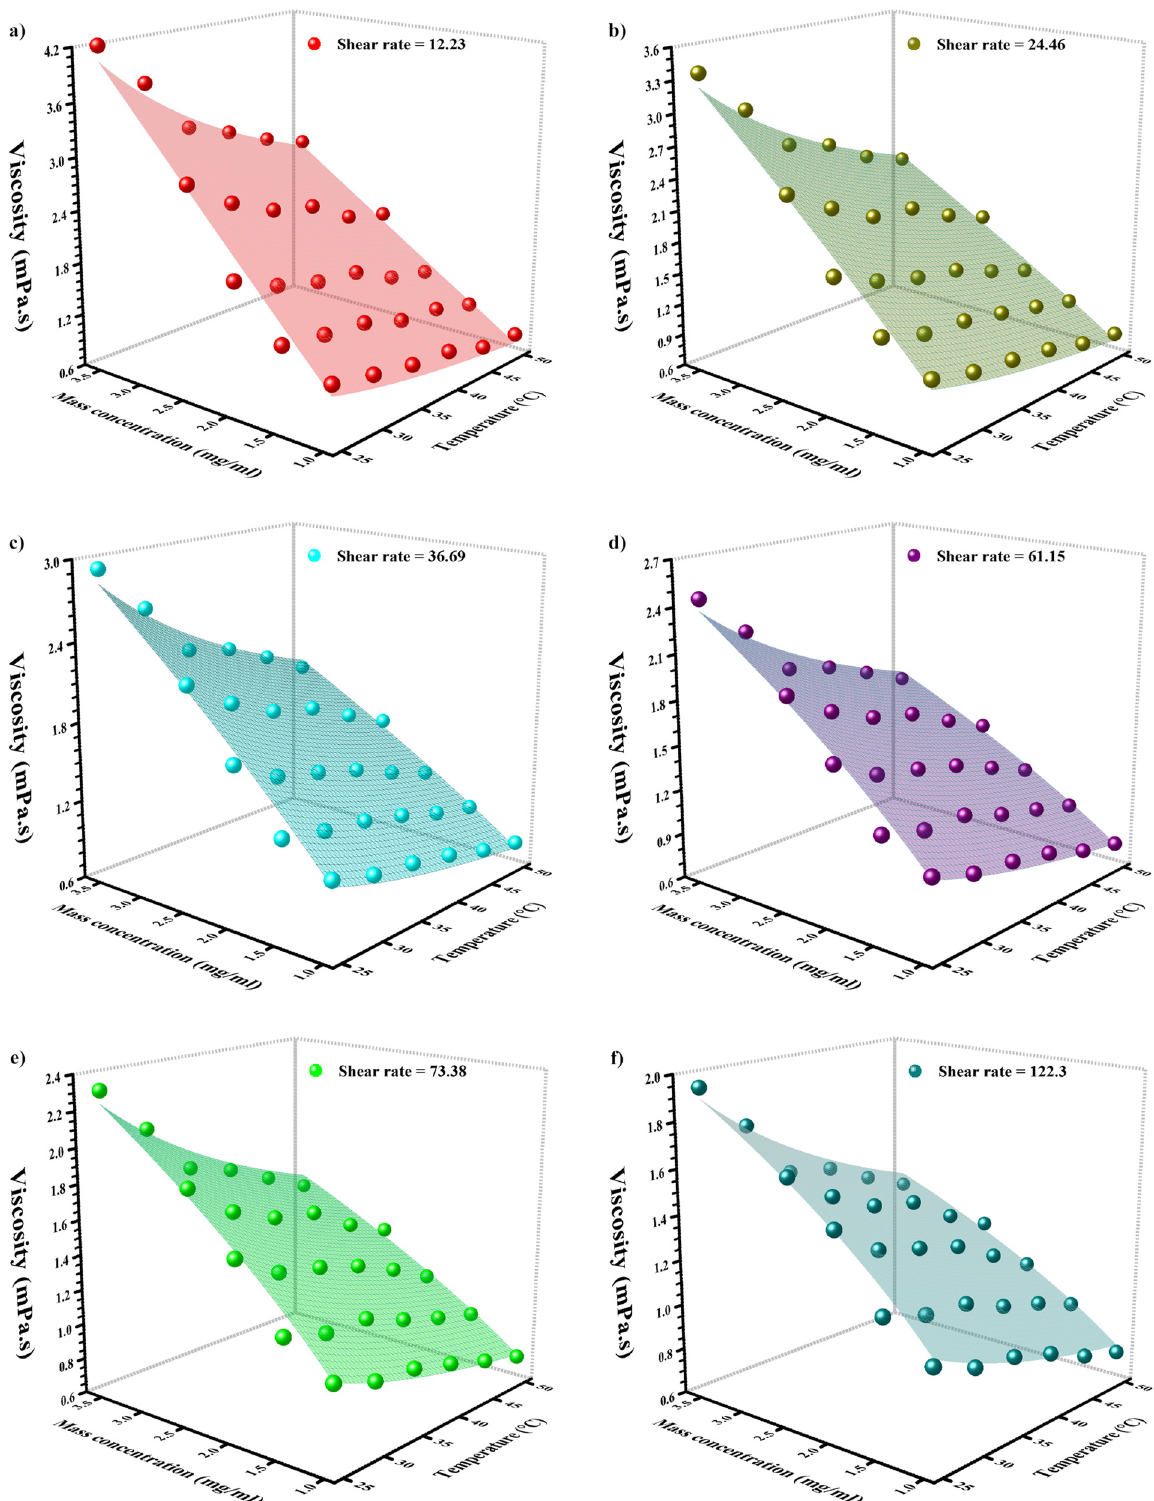
Figure 16: Con fi rmation of recommended correlation with original measurements; Viscosity via mass concentration and nano fl uid tem - perature for varied